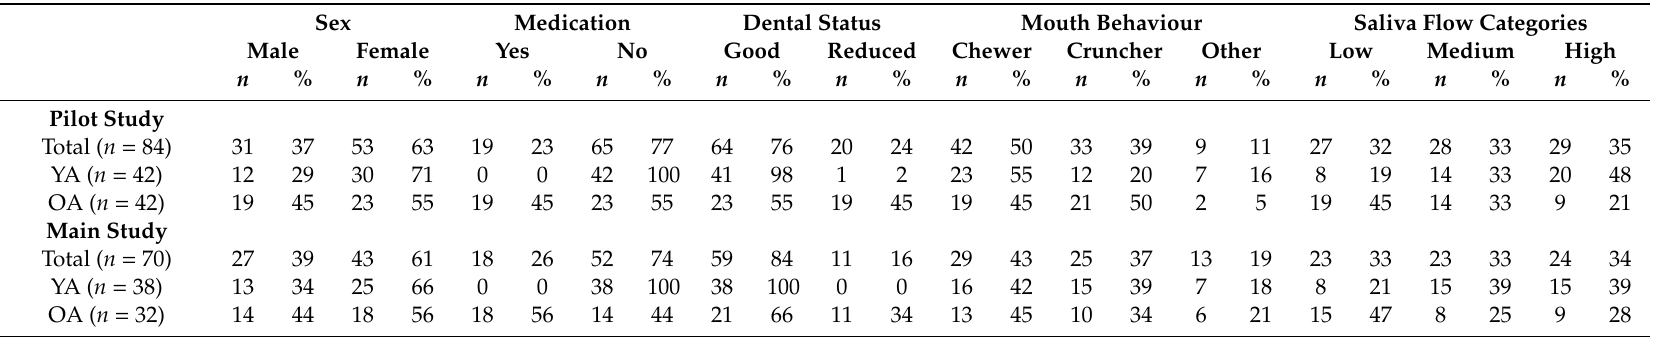
Table 5. Summary of volunteers’ sex, medication, dental status, mouth behaviour and unstimulated saliva flow groupings in both